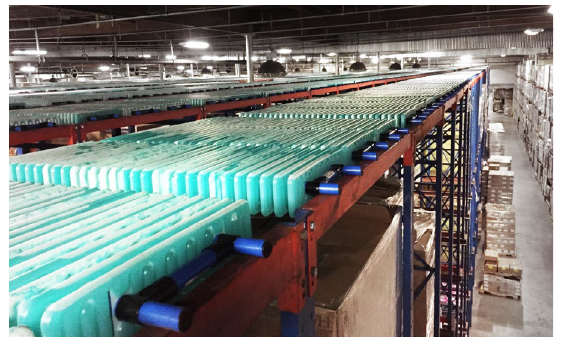
Figure 6. Approach to cool frozen food production, storage, and distribution facilities (source: Viking Cold Solutions™ Inc.).